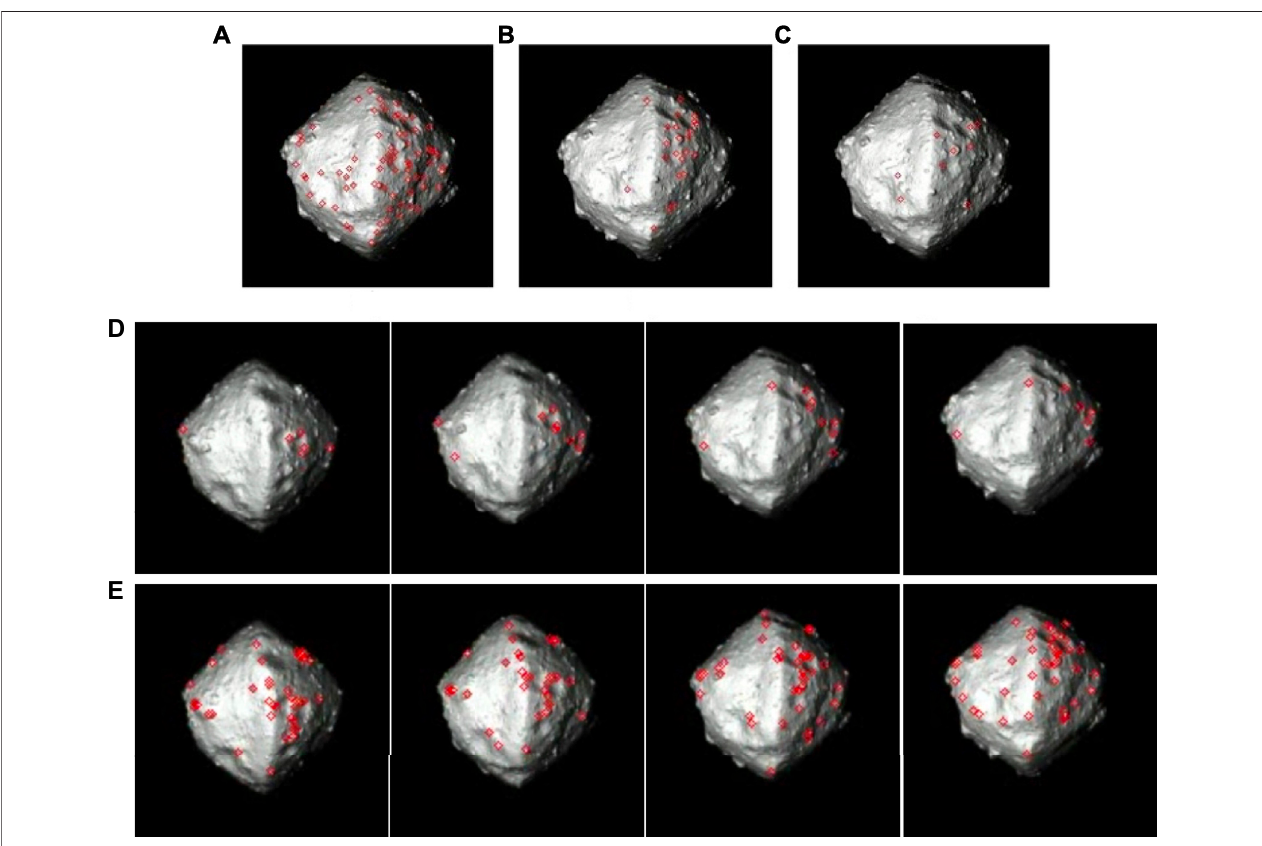
FIGURE12| Examplefeaturedistributionforthedifferentalgorithms. (A) Optical fl ow, (B) BRISK,and (C) SIFT. (D) KLTtrackingonsequentialimageswith10-min imaging. (E) KLT tracking on sequential images with 2.5-min imaging. All other parameters are unchanged.